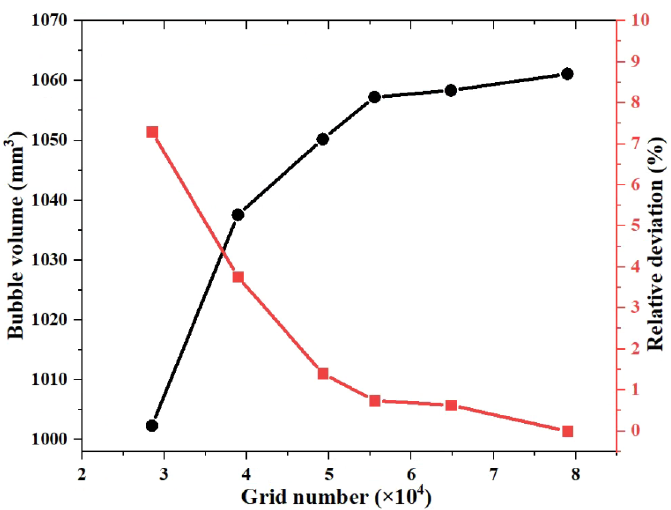
( b ) Figure 3. ( a ) Local enlargement of capillary meshing; ( b ) capillary meshing. In this study, six types of grid solution, i.e., 28,487, 38,920, 49,244, 55,512, 64,801, and